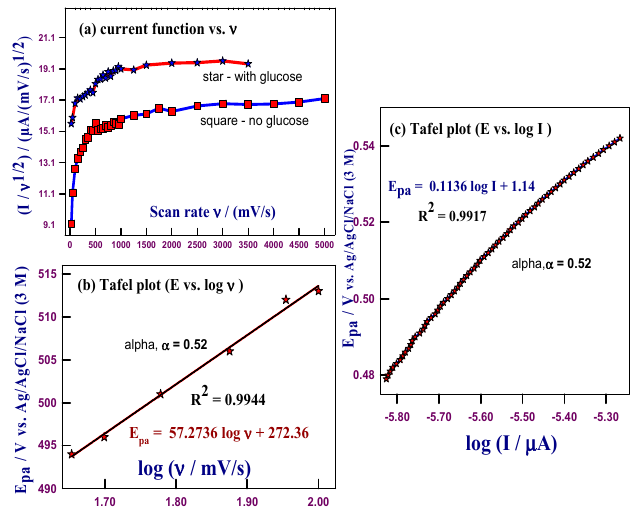
Figure 4. ( a ) Variations of the peak current function (I/ ν 1/2 ) vs. ν for the oxidation of glucose; ( b ) dependence of the peak potential, E pa on log ν ; and ( c ) Tafel plot derived from the potentiodynamic polarization curve ( I – E ) at 5 mV/s for a HCNiO/GC electrode in 0.05 M NaOH in the presence of 1 mM glucose.